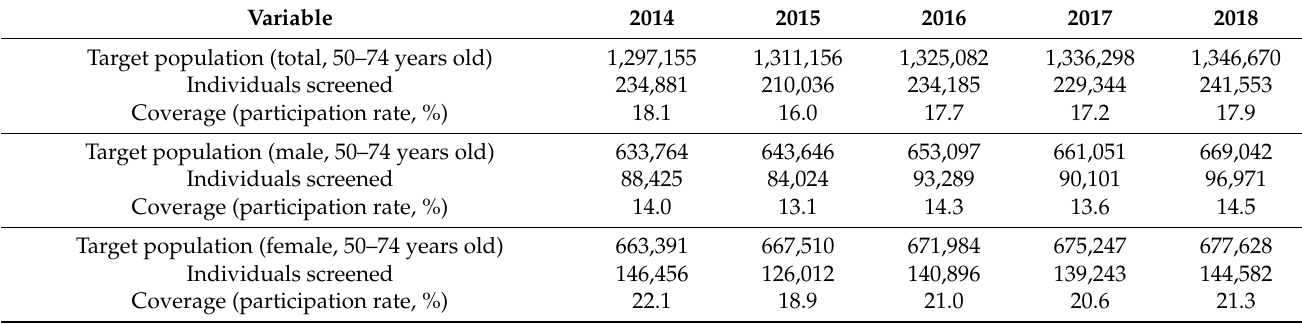
Table 1. Main performance indicators of the colorectal cancer screening program in Lithuania between 2014 and 2018.